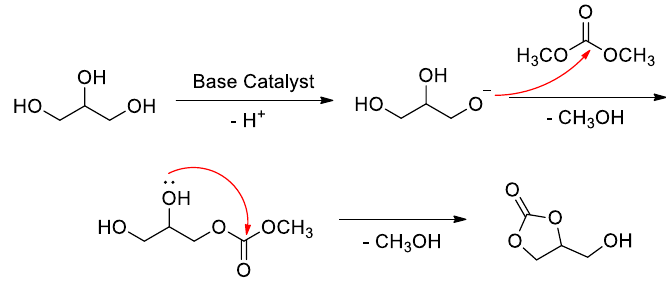
Figure 5. General procedure for the transesterification of glycerol.